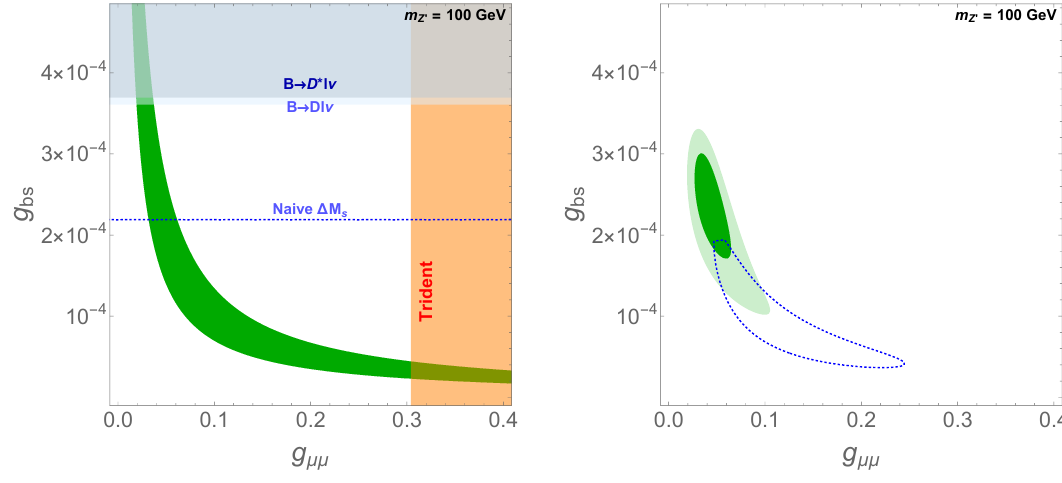
Figure 1 . Left: the parameter space in the ( g (cid:22)(cid:22) ; g bs ) plane for m Z 0 = 100 GeV preferred at 68% CL by the b ! s‘‘ anomalies (parabolic green band), compared to the regions excluded at 99% CL. by trident neutrino production (vertical orange band), and B ! D ( (cid:3) ) ‘(cid:23) (horizontal blue bands). We also show (dotted blue line) where the naive (cid:1) M s constraints would lie as applied e.g. in ref. [75]. Right: the 68% (dark green) and 95% CL (light green) regions preferred by the combination of inputs from the B -meson anomalies, trident, the B ! D ( (cid:3) ) ‘(cid:23) constraints. The dotted blue contour shows the 68% contour when B ! D ( (cid:3) ) ‘(cid:23) constraints are replaced by the naive (cid:1) M s